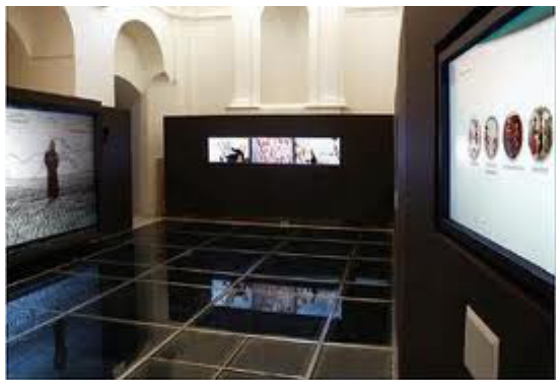
Figure 5. The interactive virtual museum of the Medical School.